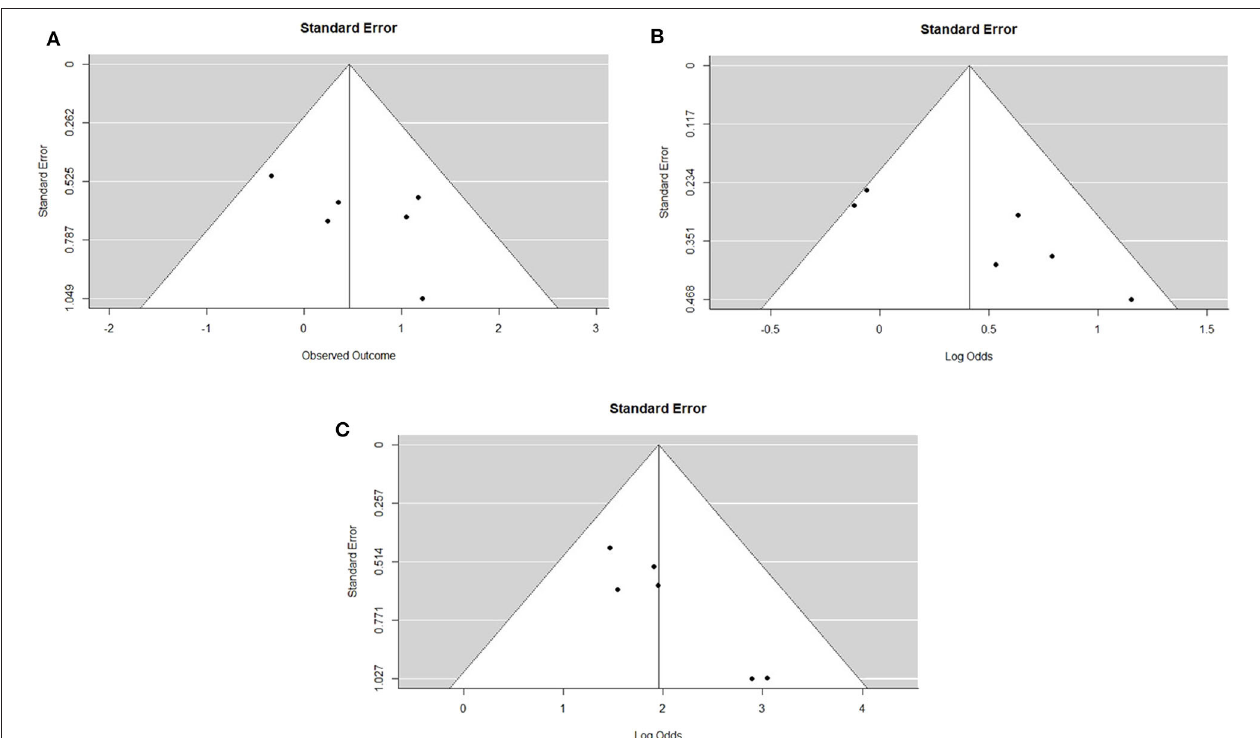
FIGURE 2 | (A) . Funnel plot for survival outcomes. Test for funnel plot asymmetry: t = 1.4439, df = 4, p = 0.2223. (B) . Funnel plot for resection outcomes. Test for funnel plot asymmetry: t = 3.2400, df = 4, p = 0.0317. (C) . Funnel plot for RO outcomes. Test for funnel plot asymmetry: t = 4.3507, df = 4, p = 0.0122.